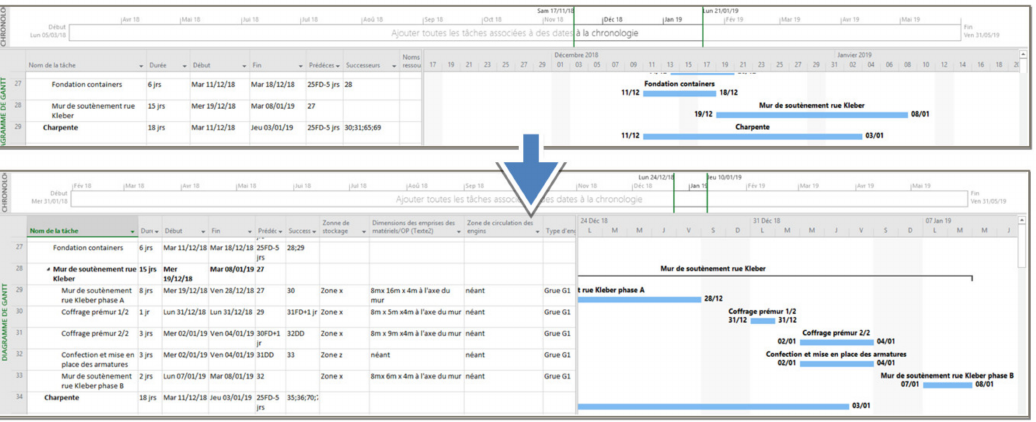
Figure 10. Evolution from initial planning to final planning (screenshot from Microsoft